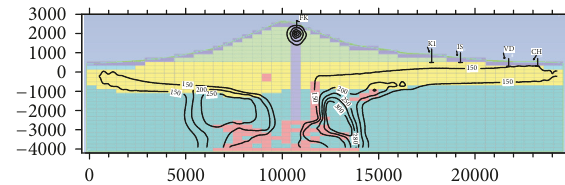
Figure 11: Distributions of modeled chloride Cl − mass fractions (TOUGH2-EOS1 + tracer) (6B + CL). Horizontal and vertical axes are labeled in meters.